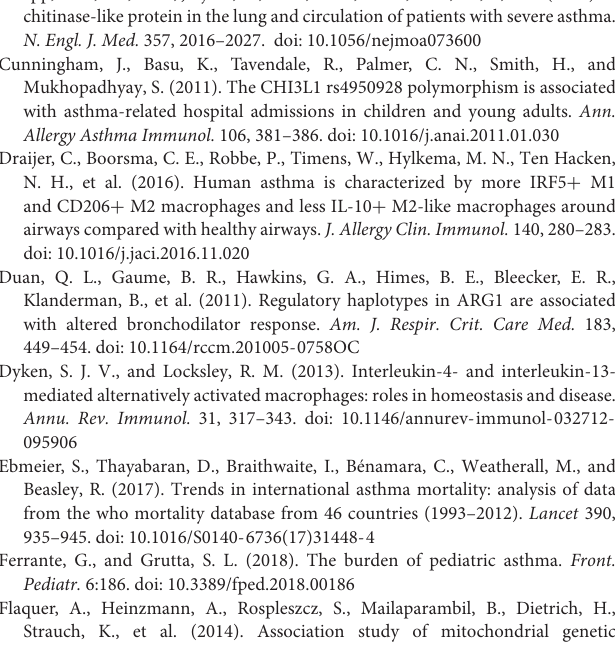
FIGURE S1 | Effect of GBFXD on expression of M2 and mitochondrial complex 1 marker in macrophages in mouse models. (A) Lung tissue was fixed and sections were processed for Immunofluorescence detection of M2 macrophage (CD206 + f4/80 + ). (B) After macrophage collected from Balf, total mRNA was isolated and examined for transcript levels of the mitochondrial complex 1 markers (NDUFA1, NDUFA9, NDUFS7, ATP5F1) by RT-PCR analysis. Values represent the means ± SE of three independent experiments with 3 replicates per experiment. ∗∗ p < 0.01; ∗∗∗ p < 0.0001; ∗∗∗∗ p < 0.0001. TABLE S1 | Primer sequences of NDUFA1 , NDUFA9 , NDUFS7 , ATP5F1